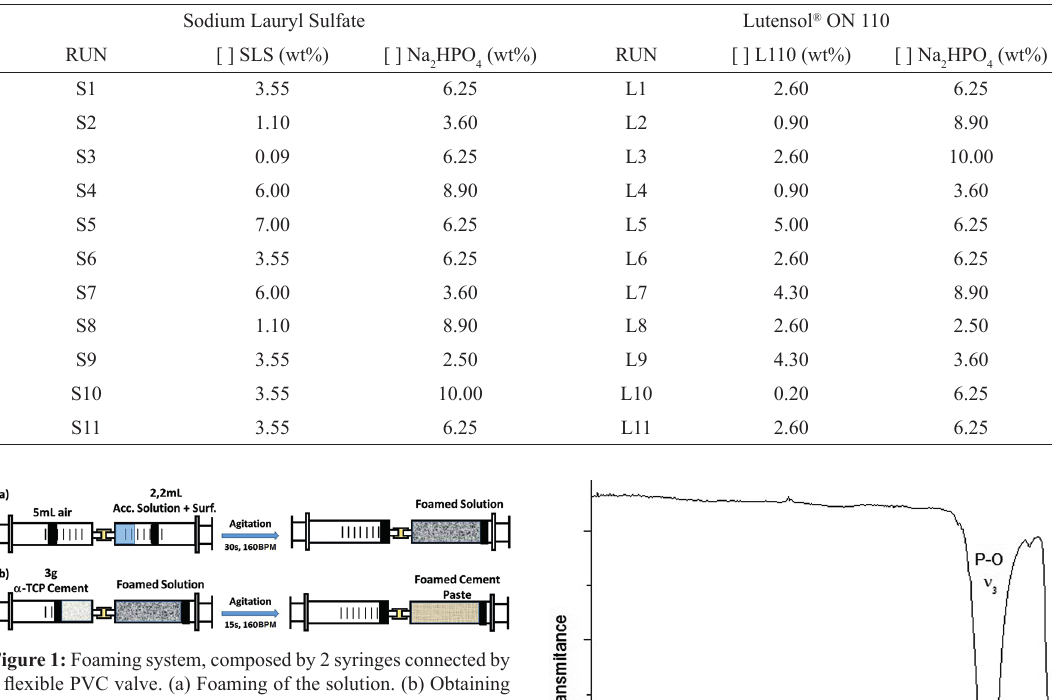
HPO and surfactant. 2 4